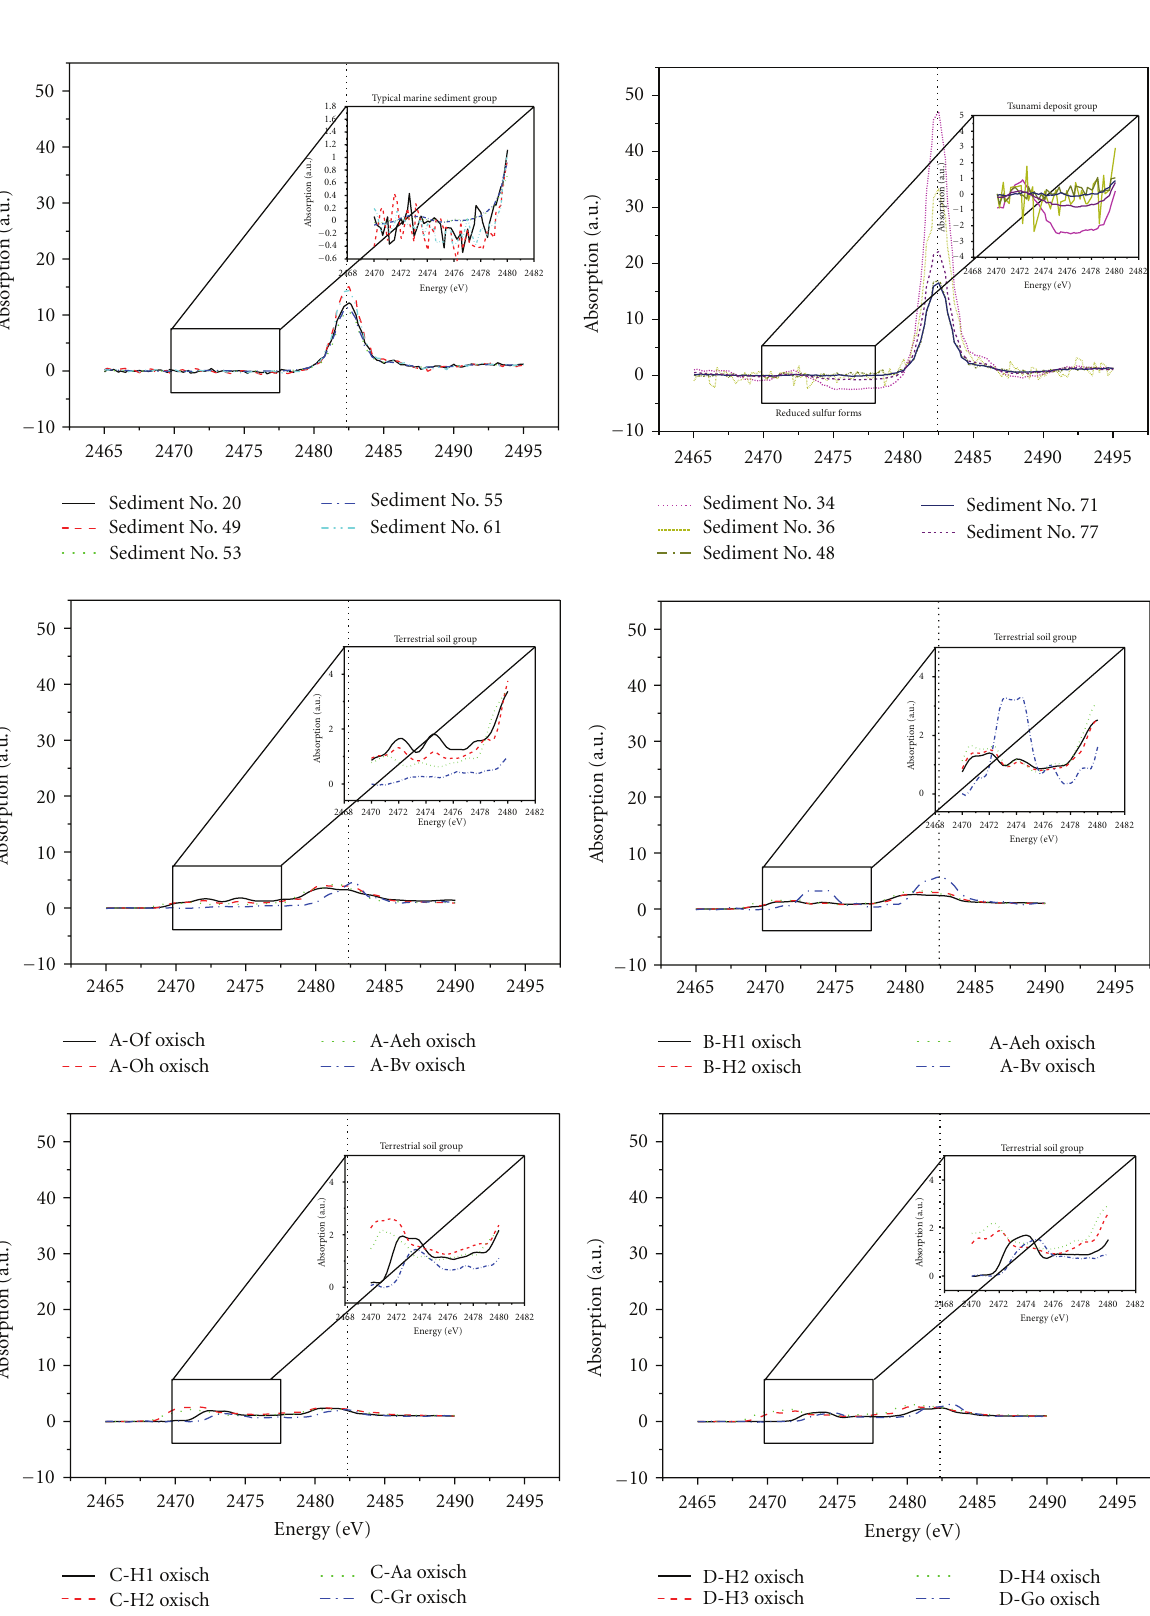
Figure 3: Sulfur K-edge XANES spectrum of typical marine sediment (TMS), tsunami backwash deposit (TBD), and German terrestrial soil